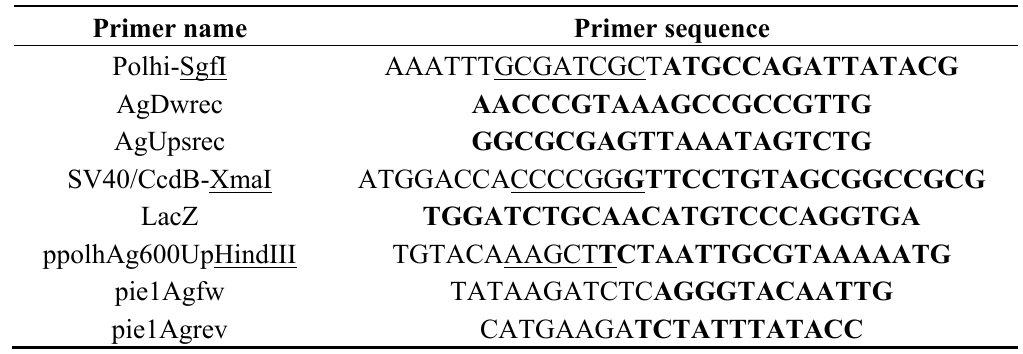
Table 2. Primers used for the characterization of cloned AgMNPV-GFP. The nucleotides that anneal with the template are highlighted in bold. Relevant restriction sites incorporated in the primers are